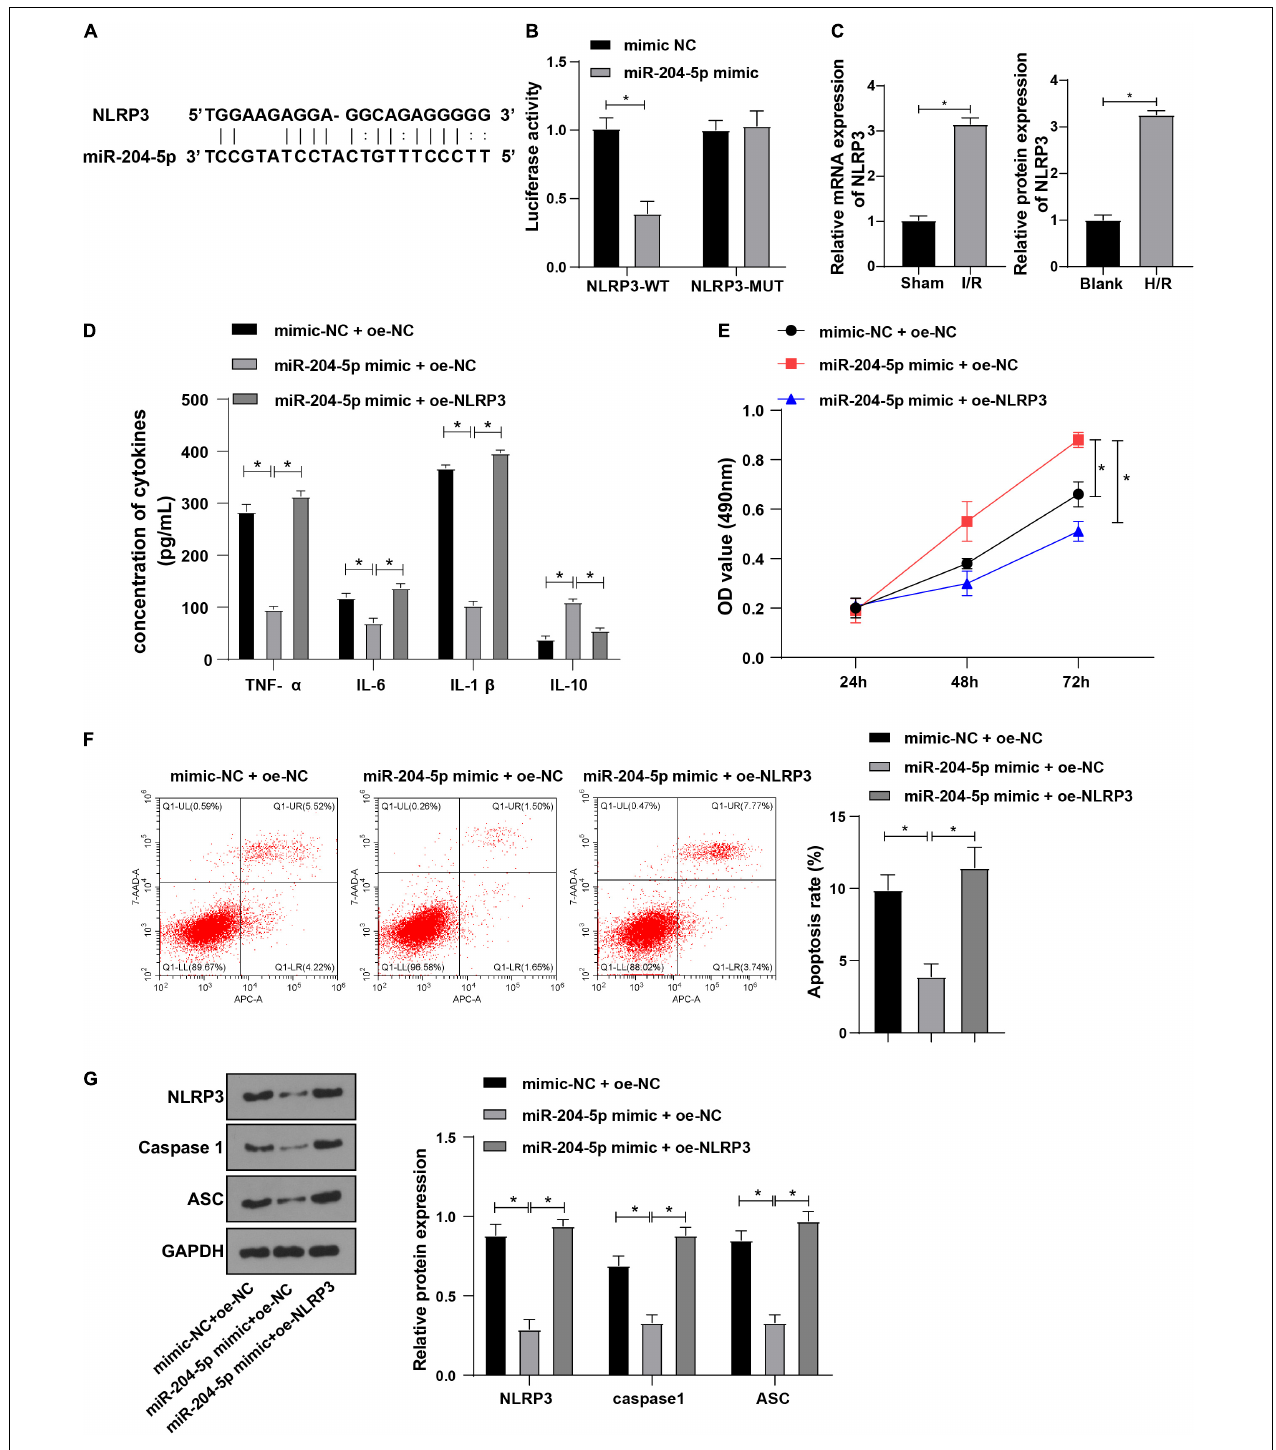
FIGURE 5 | NLRP3 overexpression averted inhibitive effect of miR-204-5p on inflammation in H/R-induced HK-2 cells. (A) Target binding sites of miR-204-5p and NLRP3 were predicted through the RNA22 website; (B) target relation between miR-204-5p and NLRP3 was verified by dual-luciferase reporter assay; (C) NLRP3 expression in AKI mouse and H/R model of HK-2 cells was detected by RT-qPCR; (D) levels of TNF- α , IL-6, IL-1 β , and IL-10 in the supernatants were detected by ELISA; (E) cell viability was detected by CCK-8 assay; (F) cell apoptosis was detected by flow cytometry; (G) levels of NLRP3 inflammasome related factors were detected by Western blot. All data in this figure were measurement data and presented as M ± SD . Comparison among multiple groups was analyzed using the one-way ANOVA and Turkey’s post hoc test while comparison among groups at different time points was analyzed using the repeated measures ANOVA, followed by Bonferroni’s post hoc test. * P < 0.05. The experiment was repeated three times.